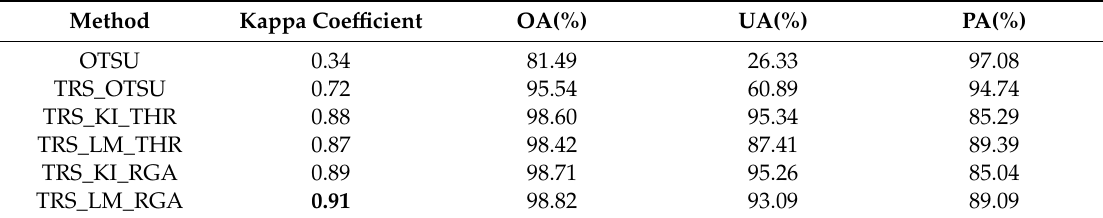
Table 4. Comparison of the accuracy using di ff erent methods for VV